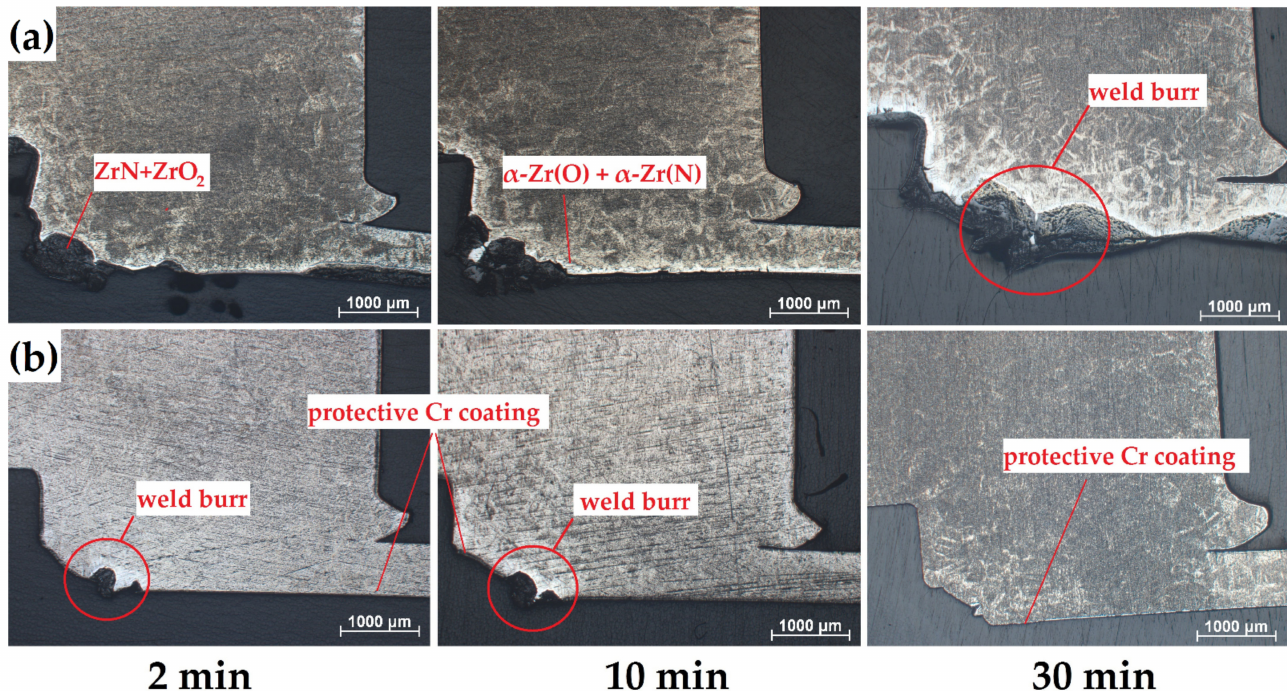
Figure 6. Optical photographs of cross-section microstructures of the ( a ) uncoated and ( b ) Cr-coated samples in the region of RUW welds after oxidation at 1100 ◦ C for 2, 10 and 30